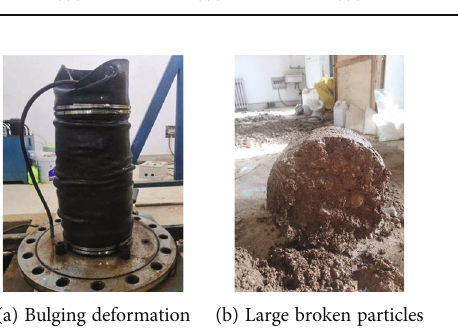
Figure 6: Failure